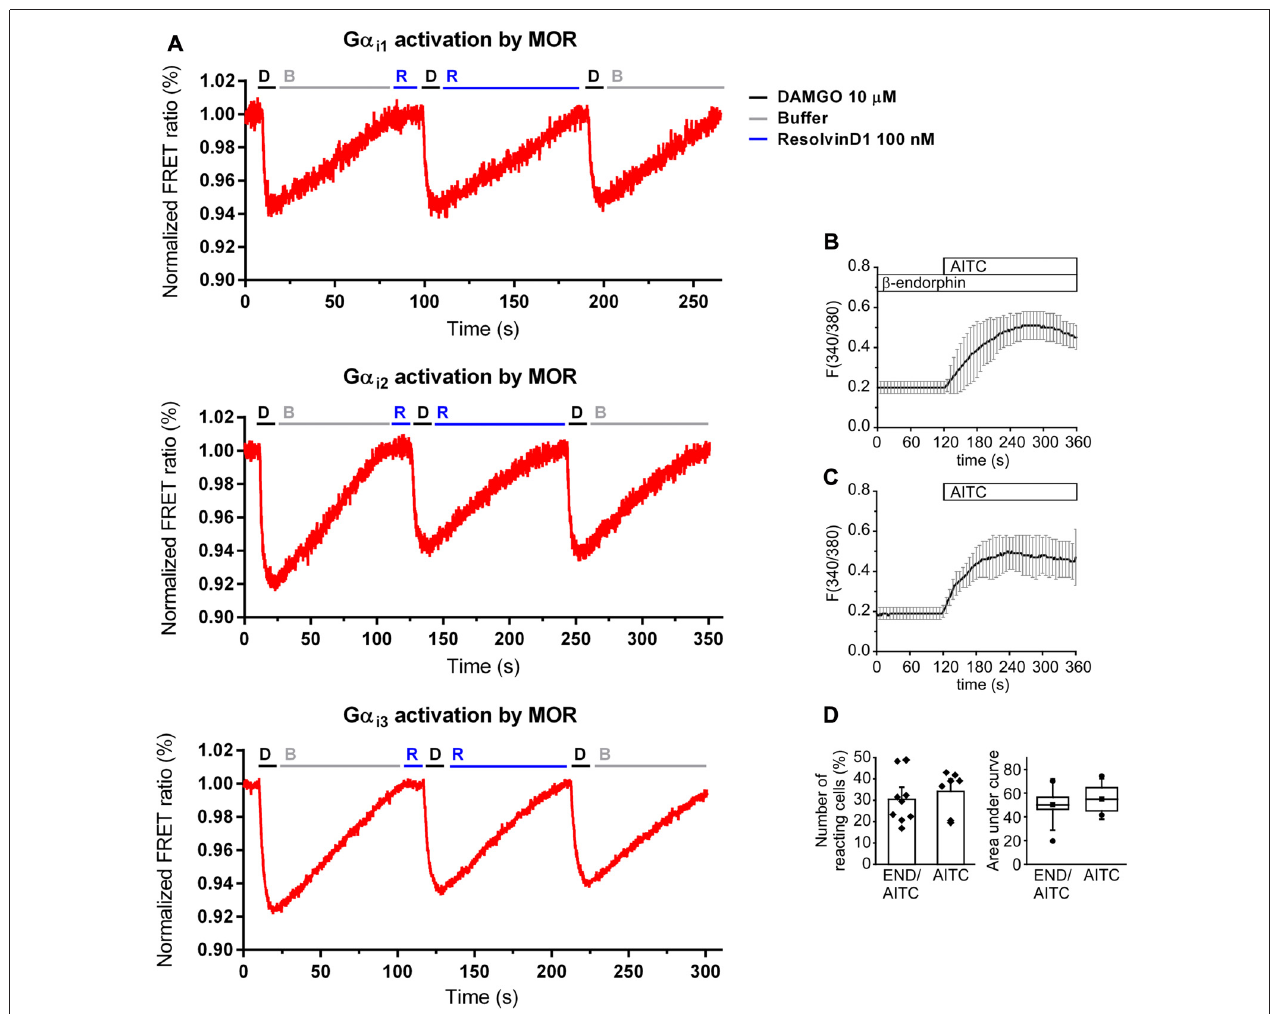
FIGURE 4 | No activation of MOR by RvD1 in HEK-293 and lack of alteration of transient receptor potential channels ankyrin 1 (TRPA1) activity by β -endophin in Dorsal Root Ganglia (DRG) neurons. (A) Activation or blockade of MOR by RvD1 (100 nM) was assessed by a Förster resonance energy transfer (FRET) assay in HEK-293 cells co-transfected with MOR and G α subunits as indicated. Representative measurements are shown. Fluorescence intensity is given as FRET ratio normalized to baseline. DAMGO (10 µ M) served as positive control. (B) Fura-2/AM-based single cell calcium imaging (ratio F(340/380)) in dissected, cultured DRGs of adult mice. Preincubation of the DRGs in β -endorphin (100 nM, 5 min) did not further increase intracellular calcium upon TRPA1 stimulation with allyl isothiocyanate (AITC ; 10 µ M). Traces represent mean ± SD of 7–9 independent measurements per group. (C,D) Statistical analysis of the number of reacting cells (C) and the area under curve (D) demonstrate no significant differences between the treatment groups. (AITC: n = 7; pretreatment with β -endorphin: n = 9; mean ± SEM, student’s t -test, p < 0.05).